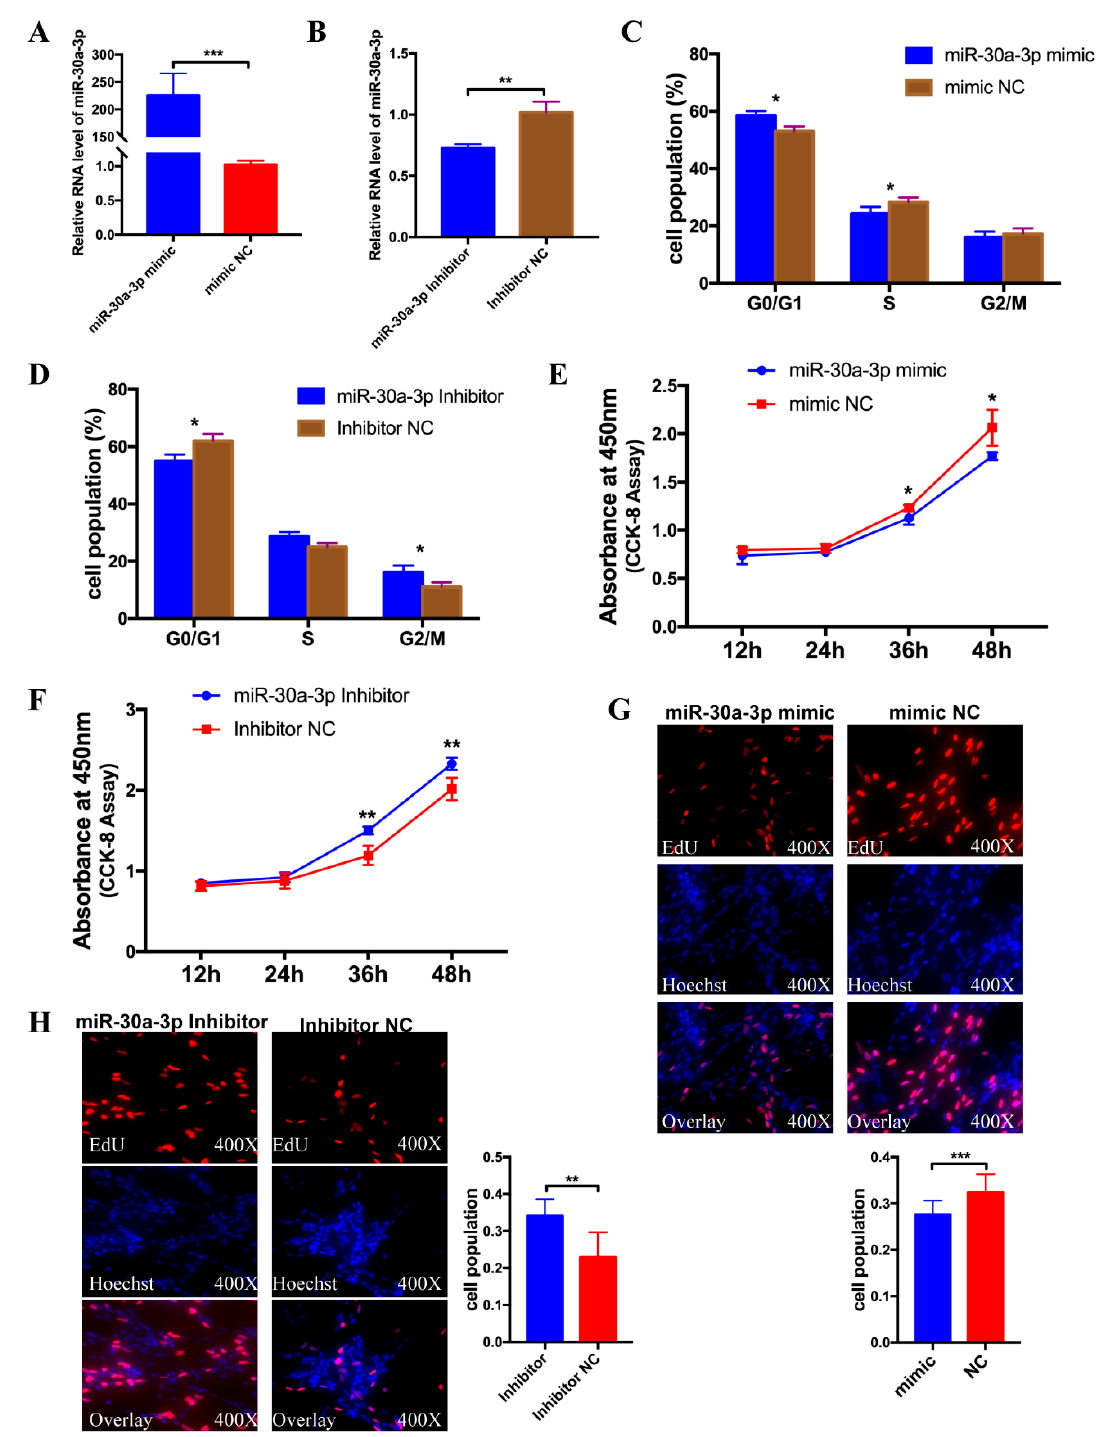
Figure 3. miR-30a-3p inhibits myoblast proliferation. ( A , B ) The over-expression and inhibitory effects of miR-30a-3p mimic and inhibitor in CPMs. ( C , D ) Effect of miR-30a-3p mimic and inhibitor on cell-cycle progression of chicken primary myoblasts (CPMs). The plot of cell-cycle analysis in different cell-cycle phases was compared. ( E , F ) The growth curves of CPMs were measured after the transfection of miR-30a-3p mimic and inhibitor. ( G , H ) 5-Ethynyl-2 ′ -Deoxyuridine (EdU) assays for CPMs with over-expression and inhibition of miR-30a-3p. In all panels, values represent mean ± SEM from three independent experiments. * p < 0.05; ** p < 0.01; *** p < 0.001.